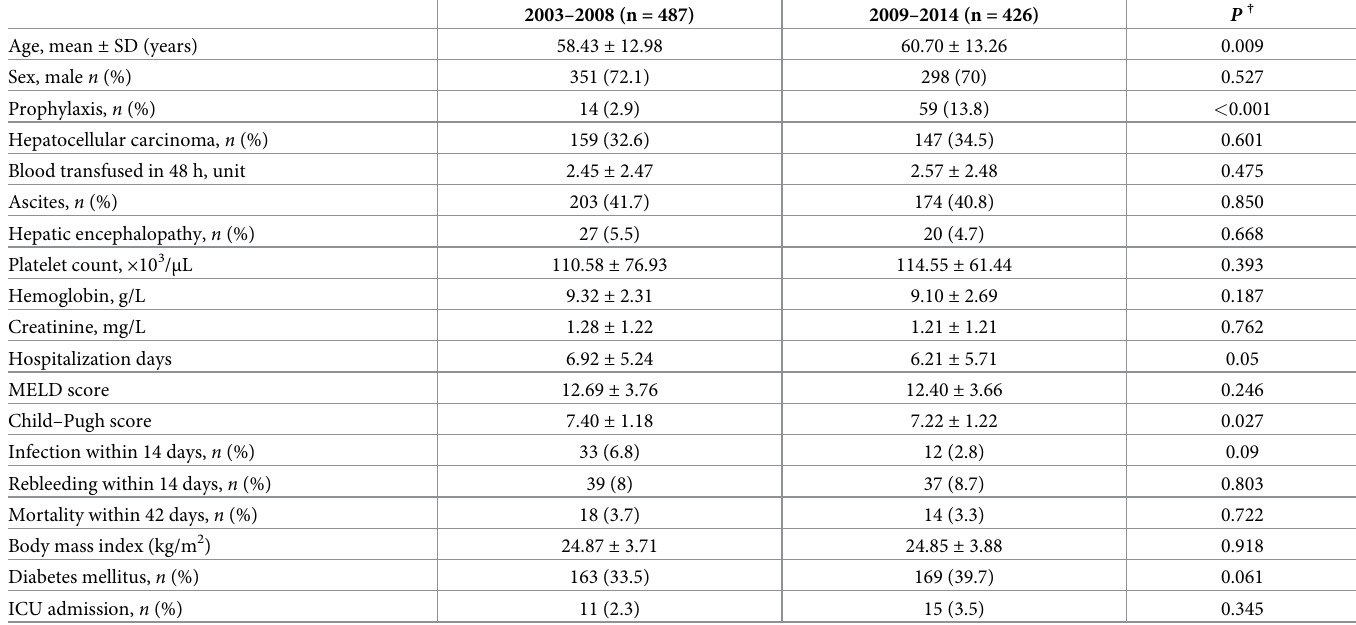
Table 2. Changes in patient characteristics and results over